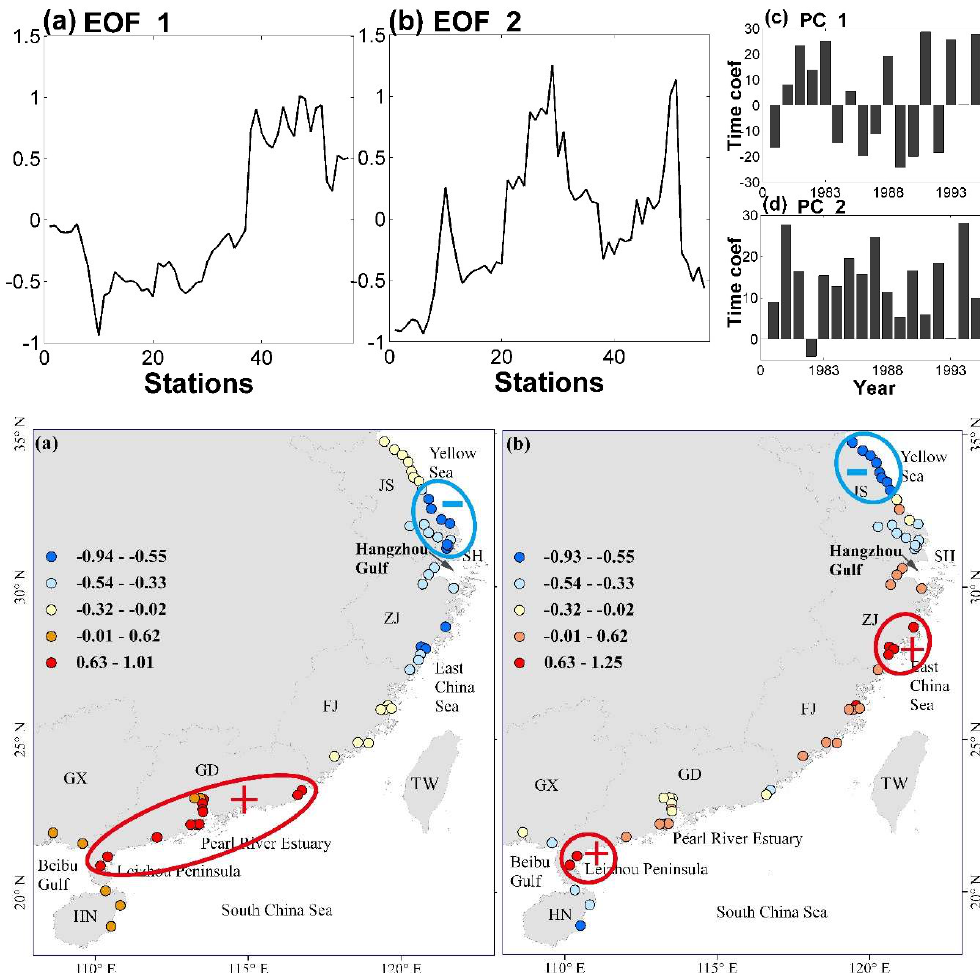
Figure 7. ( a–d ) The first two leading EOF modes and the PCs of ASPI during the period of 1979–1995 In summary, the dominant mode changes in the different patterns of the three In the period from 1979 to 1995, the interpretation variance of these two modes are 38.1% and 26.7%, respectively, and the accumulated variance of the first two leading modes is 64.8%. The first leading mode of ASPI in Figure 7a exhibited a -+ dipole pattern. The largest storm surge threat was located on the coast area from the Pearl River Estuary to the western coastline of Guangdong province. The smallest storm surge threat was along the southern coast line of Jiangsu province. The second mode showed a -++ tripole pattern in Figure 7b. The largest storm surge threat was located on the southern coastline of Zhejiang province and the western coastline of Guangdong province. The smallest was along the northern coastline of Jiangsu province. The time coefficient of the first mode showed a large amplitude fluctuation and significantly weakened, while it was stronger in the second mode(see Figure 7c,d). It turned out that the amplitude of the -+ dipole pattern became weaker, while the -++ tripole pattern became stronger. Great changes have taken place in the spatial distribution of storm surge threat of these two leading modes. The storm surge threat along the coastline of the center to the east of Guangdong province was weaker than that of the previous period, while the threat of the center to the southern coastal area of Zhejiang province became stronger.